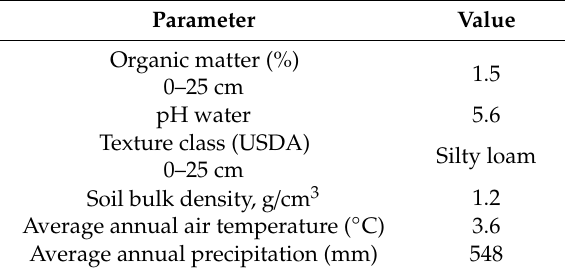
Table 2. Parameters of the standard scenario of the PEARL 4.4.4 model for the Moscow